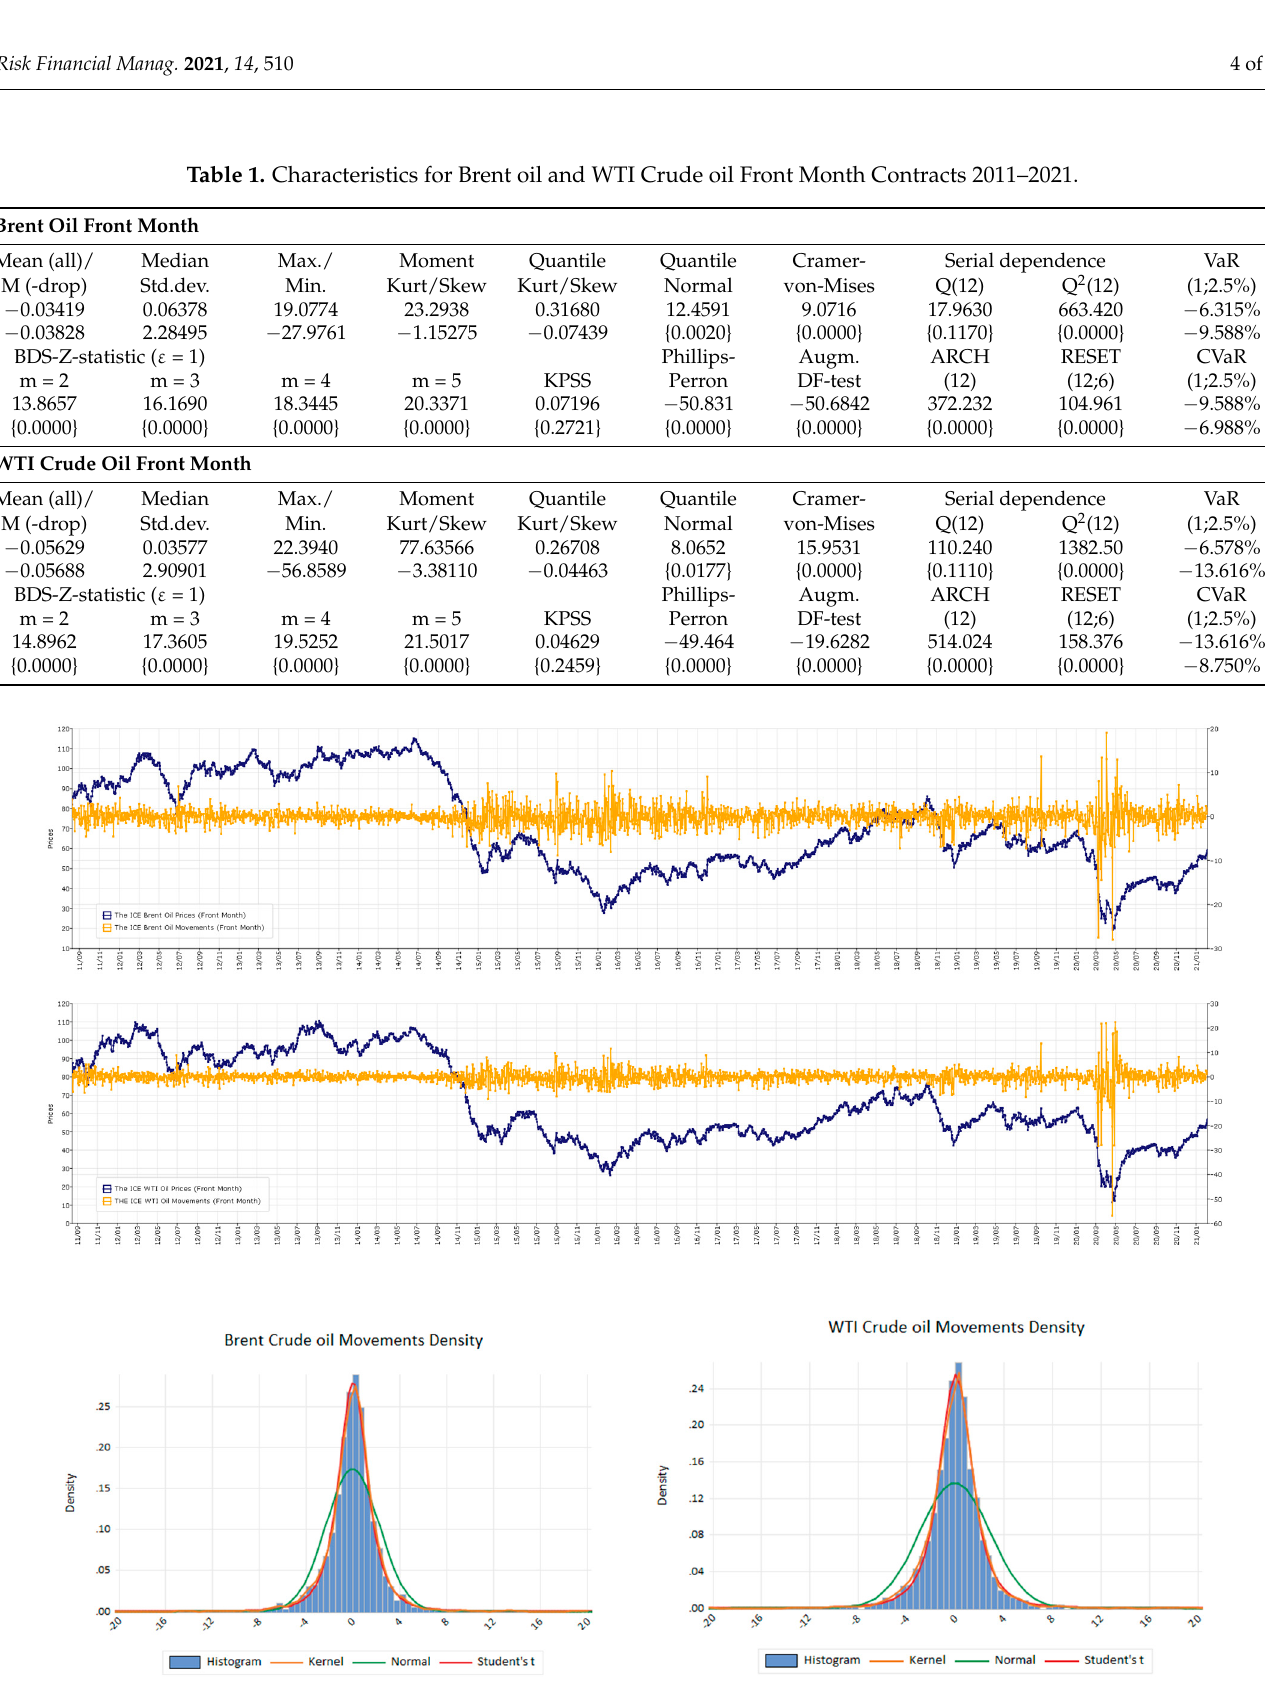
Table 1. Characteristics for Brent oil and WTI Crude oil Front Month Contracts 2011–2021.